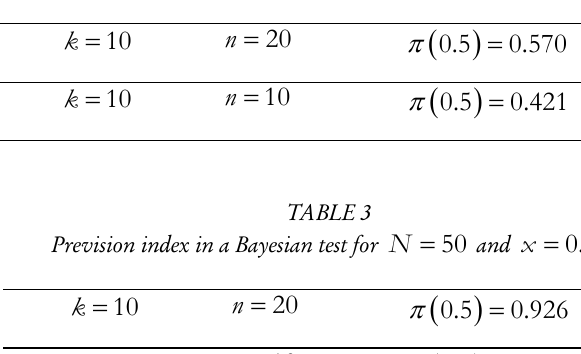
Prevision index in a frequentist test for